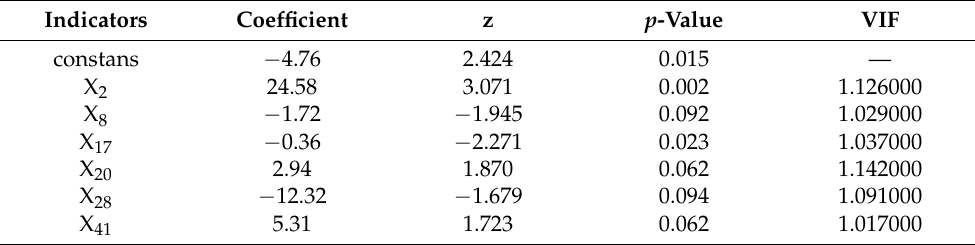
Table 4. Logit regression function for insolvency prediction of construction companies (ZRL).